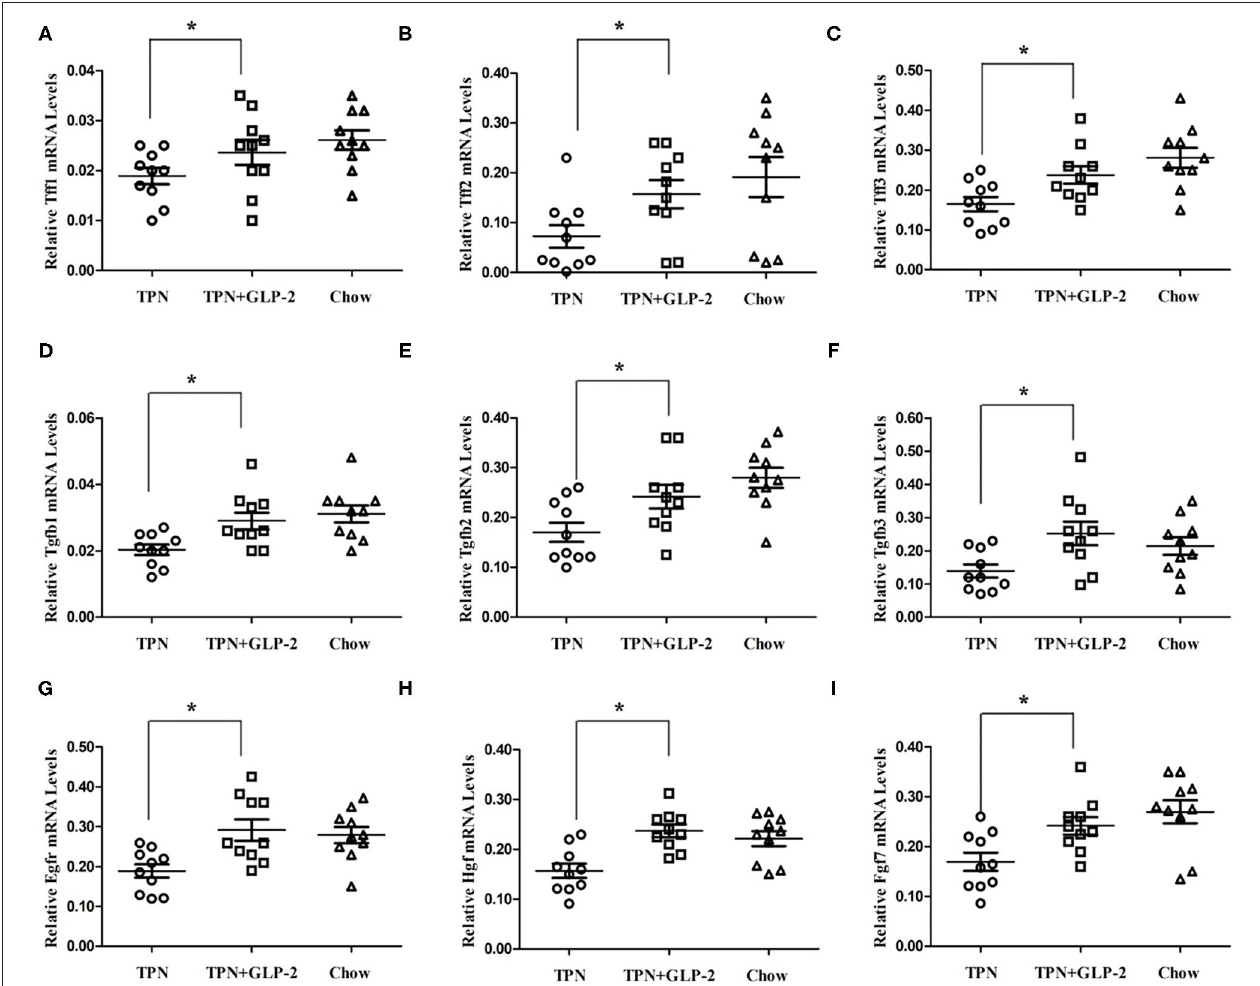
FIGURE 3 | The intestinal tissue the expression of epithelial protection and repair genes. (A–I) [trefoil factor-(Tff)1,2 and 3; transforming growth factor-(Tgf) b1,2 and 3; epidermal growth factor receptor (Egfr); hepatocyte growth factor (Hgf); keratinocyte growth factor (Fgf7)], where *indicates p < 0.05 for TNP vs. TPN + GLP-2 and